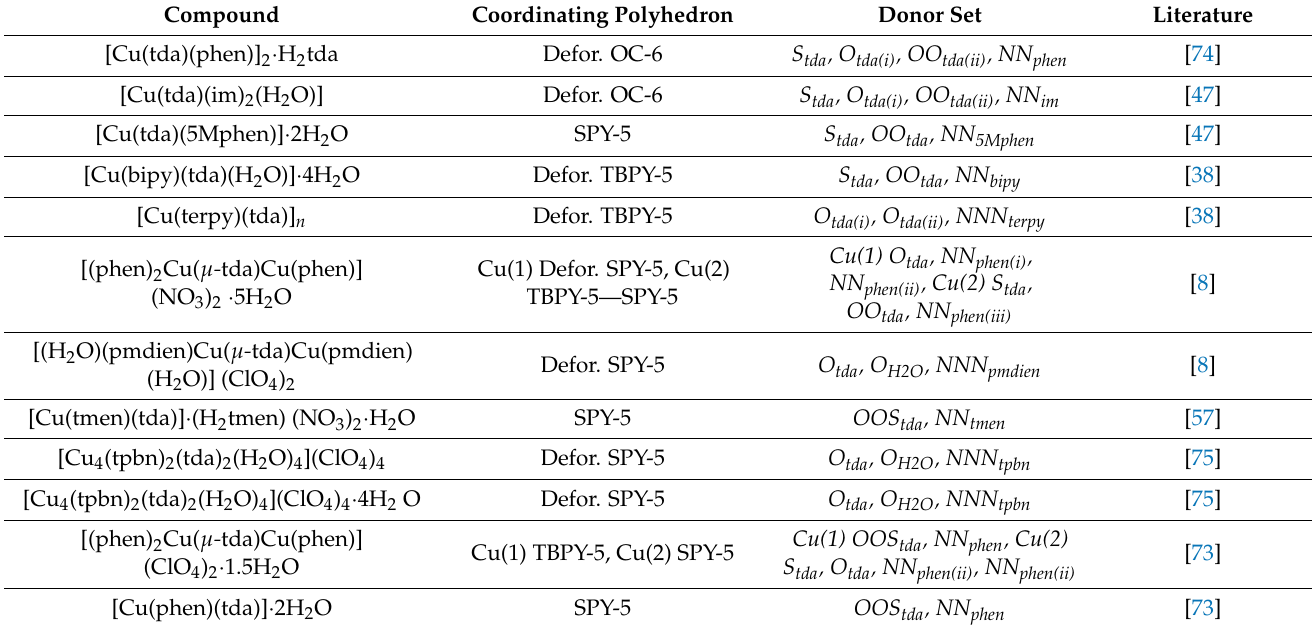
Table 1. Summary of structurally characterized coordination compounds of copper with 2,2 1 - thiodiacetic acid and N donor ligands. For the donor atoms, the lower cursor indicates the ligands of which they are a